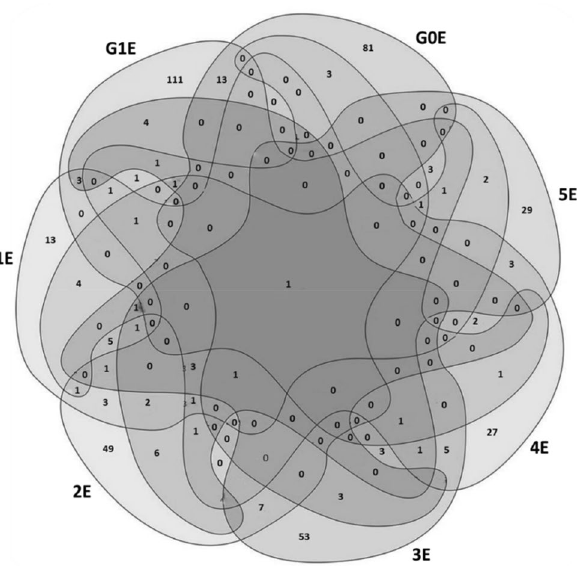
Figure 3. Venn diagram of the proteins identified by MS/MS exclusively in the ecchymotic skin in the comparison 1E versus 2E versus 3E versus 4E versus 5E versus G0E versus